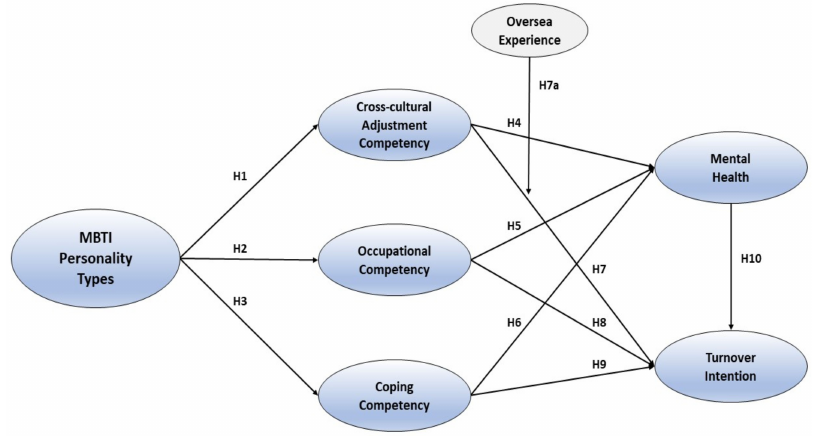
Figure 1. Conceptual